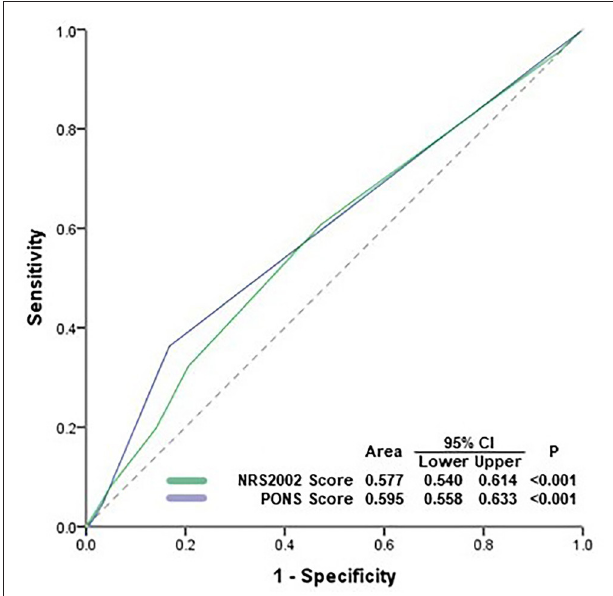
FIGURE 2 | Receiver operating characteristic (ROC) analysis. ROC curve analysis showed that the performances of PONS and NRS2002 were poor in predicting postoperative complications. PONS, perioperative nutrition screen; NRS2002, Nutritional Risk Screening 2002; AUC, area under curve; CI, confidence